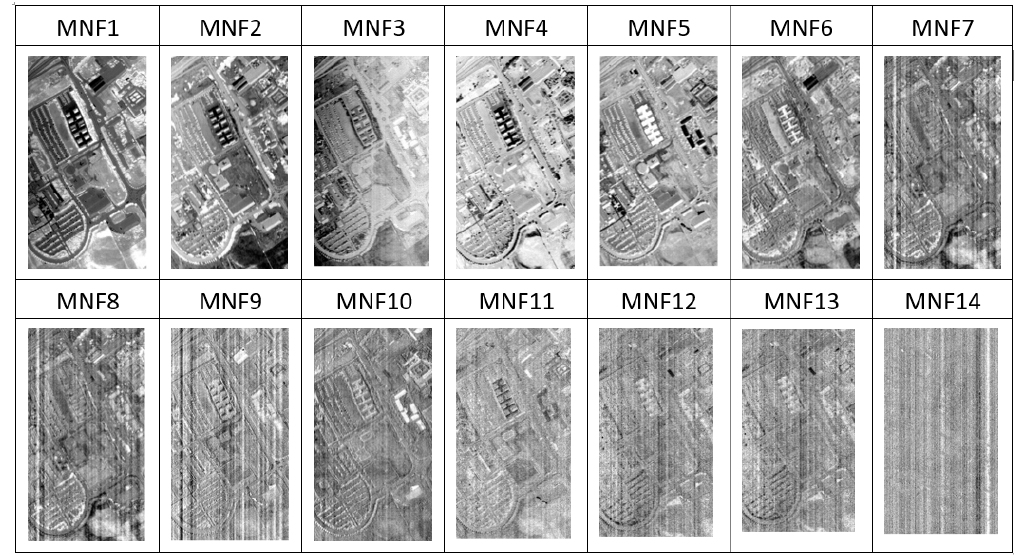
Figure 14. MNF1 to MNF14 images of the PaviaU dataset.